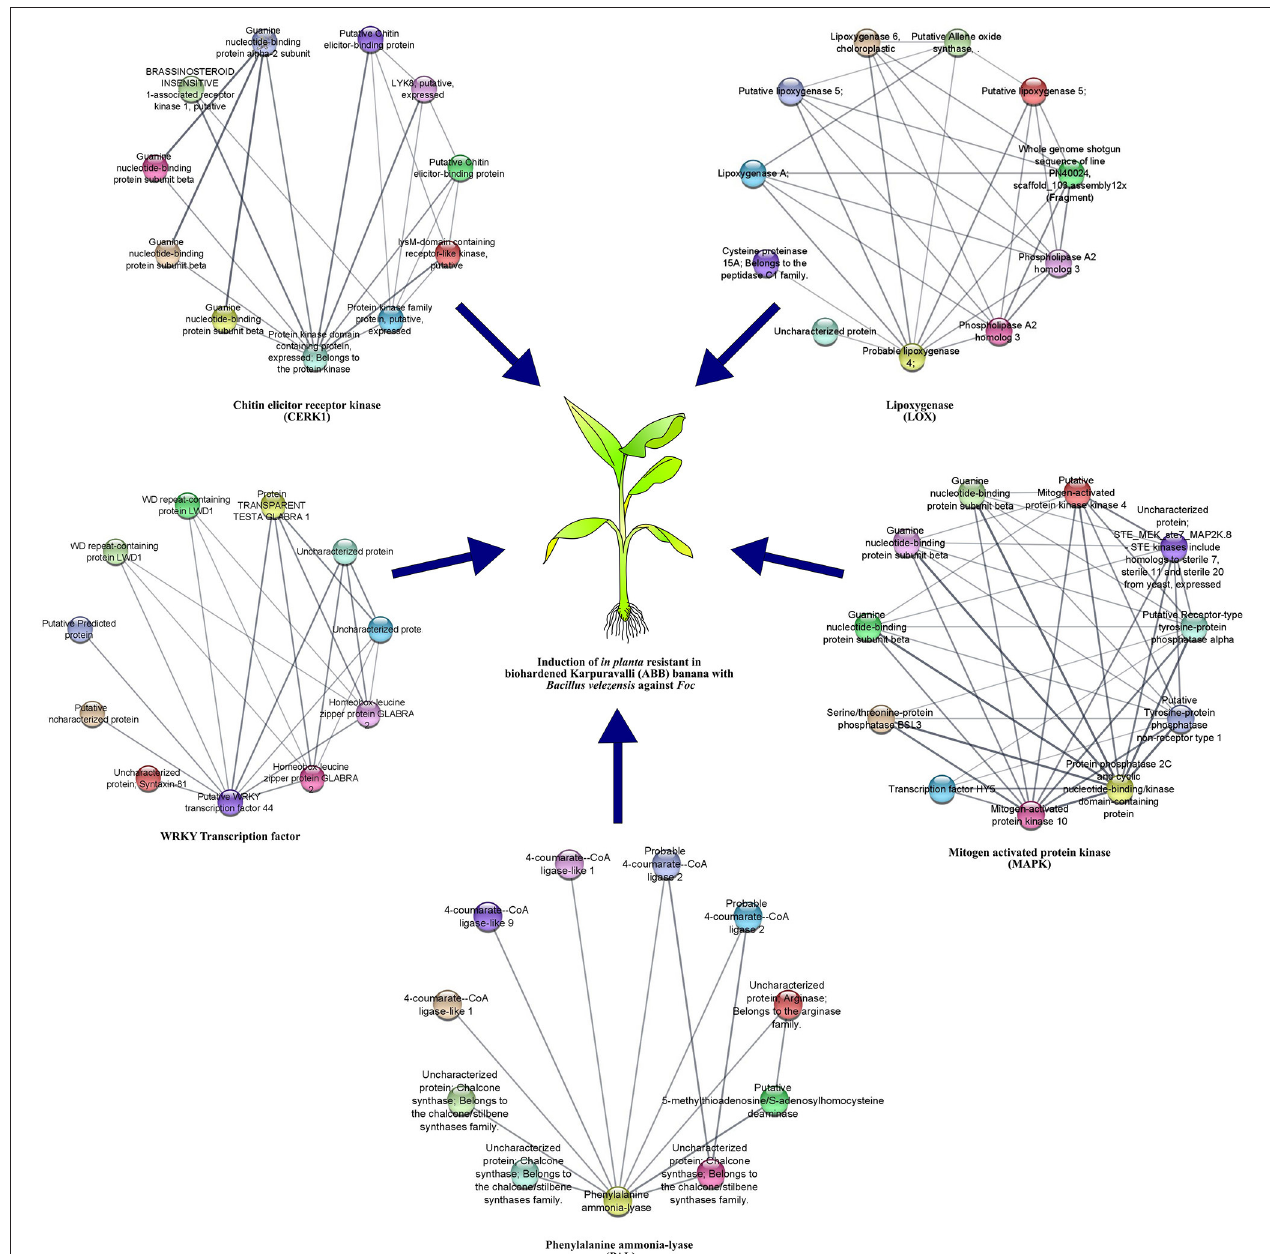
FIGURE 6 | Protein-protein interaction analysis of defense